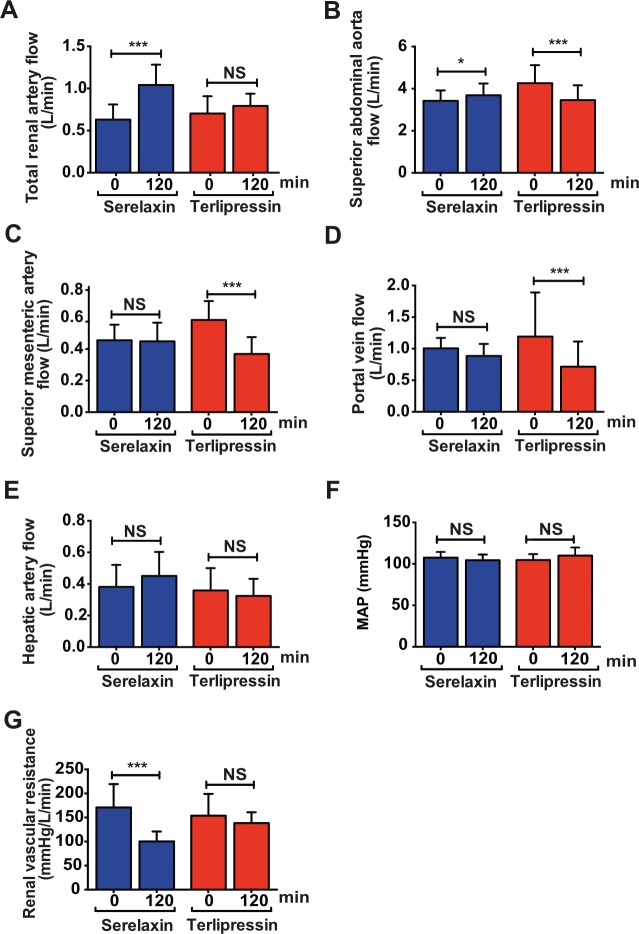
Differential effects of serelaxin and terlipressin treatment on splanchnic and extra-splanchnic hemodynamics.Blood flow changes in total renal artery (left + right renal artery; A), superior abdominal aorta (B), superior mesenteric artery (C), portal vein (D), and hepatic artery (E); mean arterial pressure (MAP; F); and renal vascular resistance (G) following serelaxin infusion (60 min at 80 μg/kg/d then 60 min at 30 μg/kg/d) or terlipressin (2-mg i.v. bolus). Data presented as geometric mean ± 95% CI, analyzed by paired t-tests for within-group comparison of baseline and post-treatment flow measurements (n = 20; *p < 0.05; ***p < 0.001; NS, not significant).